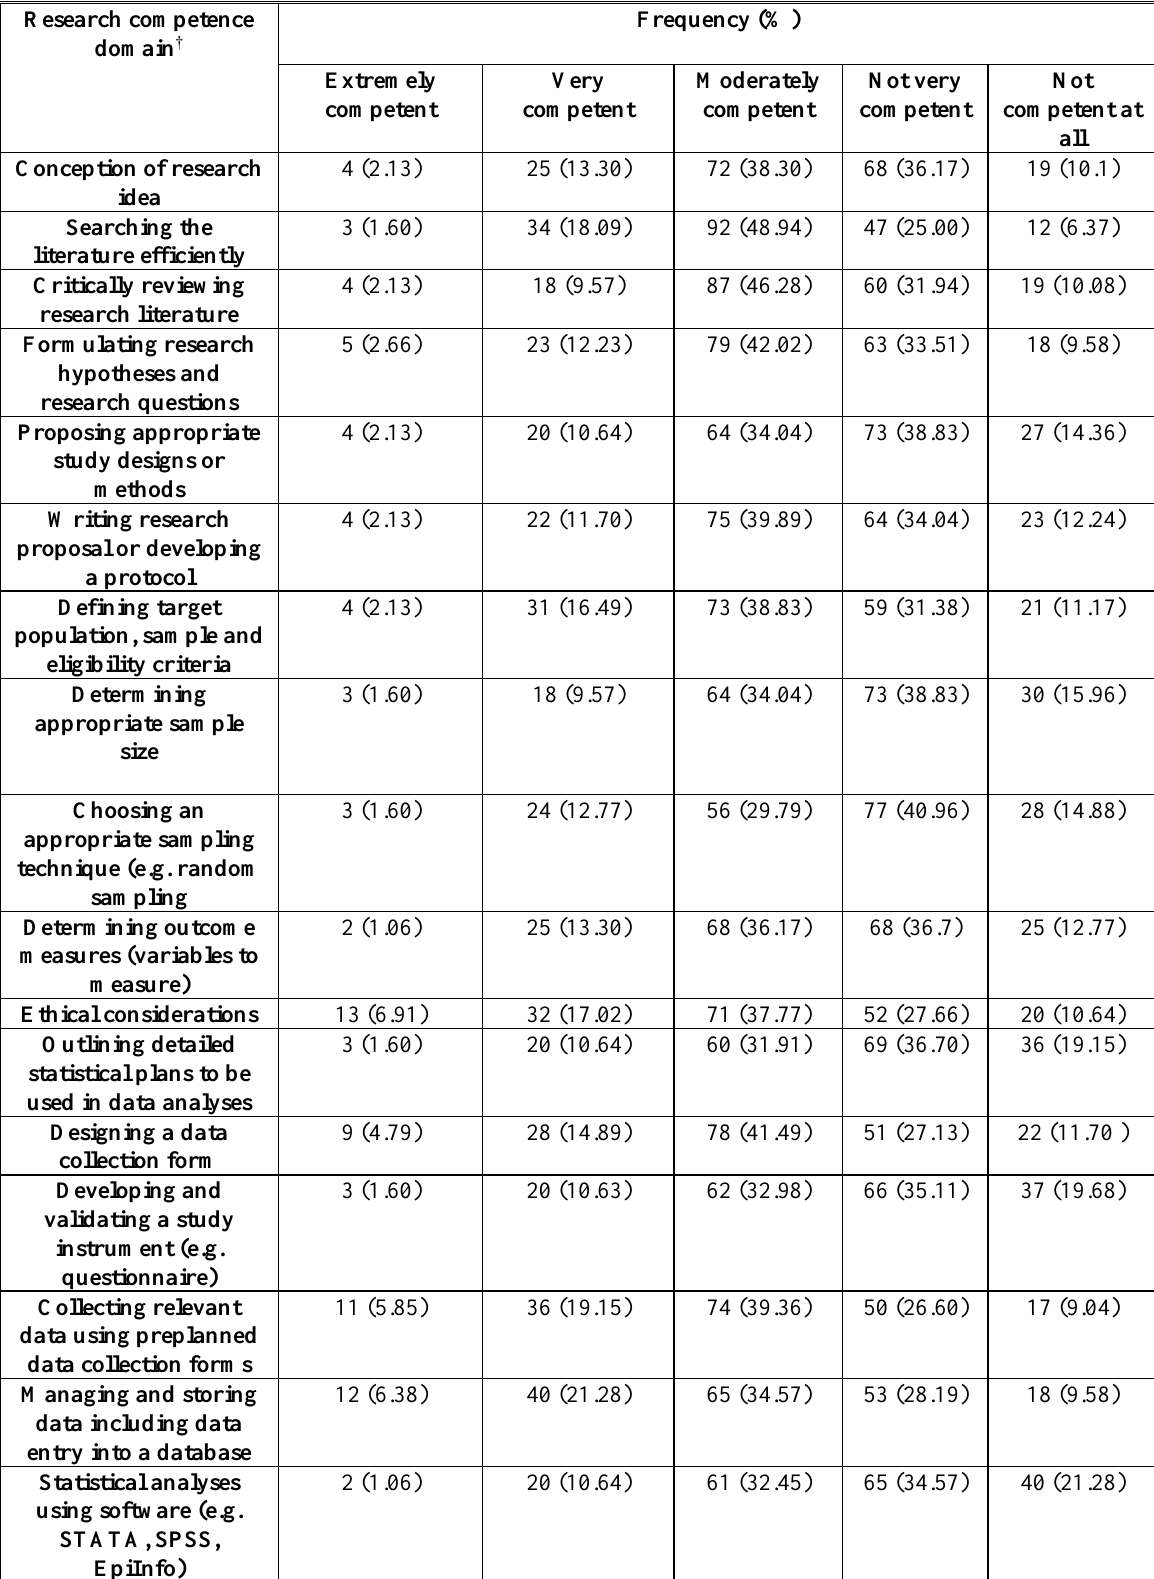
Table 3. Self-perceived competence of hospital pharmacists in planning and conducting research (n=